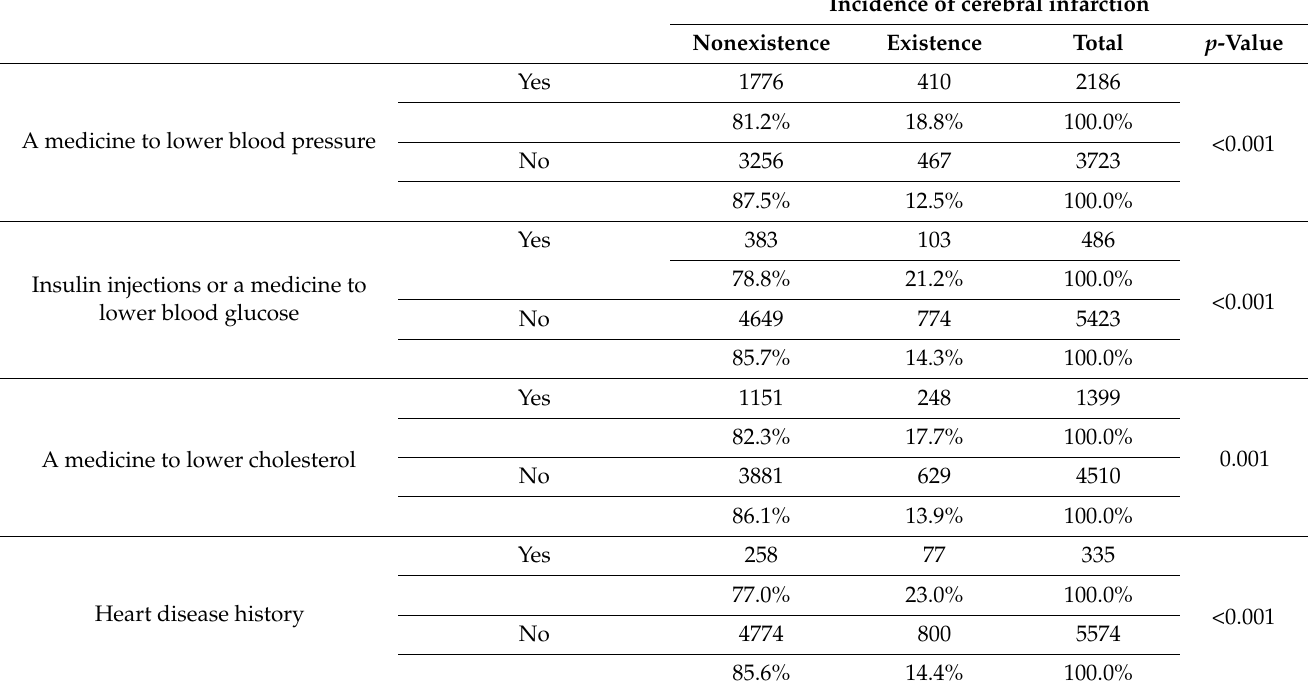
Table 2. Cross-tabulation results of questionnaires conducted in 2009 and incidence of cerebral infarction in